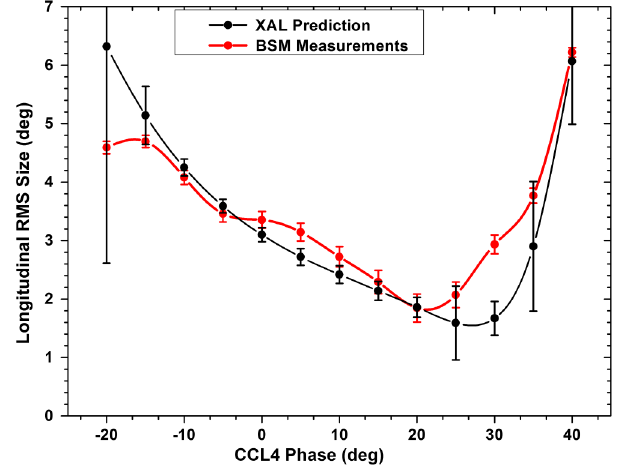
FIG. 4. The longitudinal beam profile measured by the BSM in the CCL. The red curve is a Gaussian fitting.